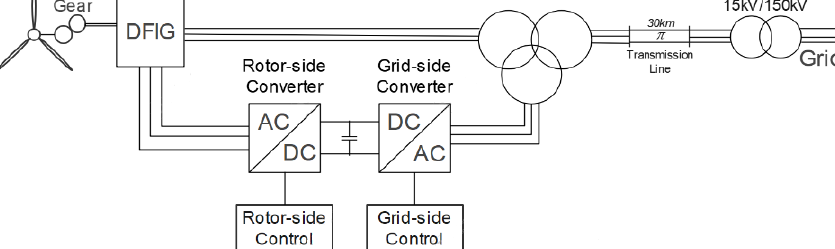
Figure 10. Proposed grid-connected DFIG-based WECS system. Table 1. DFIG parameters.